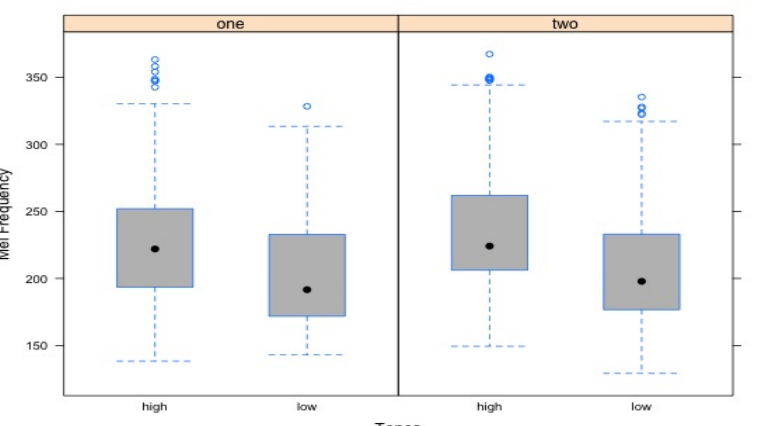
Figure 20: Mid vowel positions of the two vowels in disyllables. One indicates the vowel of the first syllable; two indicates the vowel of the second syllable. Diagram shows the overall differences across speakers.